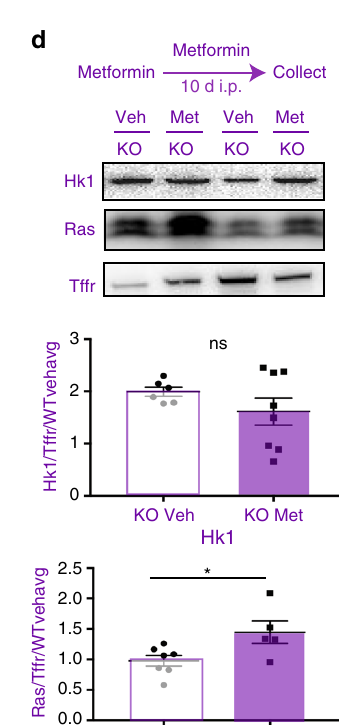
deviations outside the average for controls (3 patients in GRIN2B and 2 in BDNF, red boxes), with additional patients between 1 and 2 standard deviations outside average for controls (2 in GRIN2B and 3 in BDNF) (Fig. 5b, c). mGluR5 and SYNGAP did not demonstrate any population differences, although 6